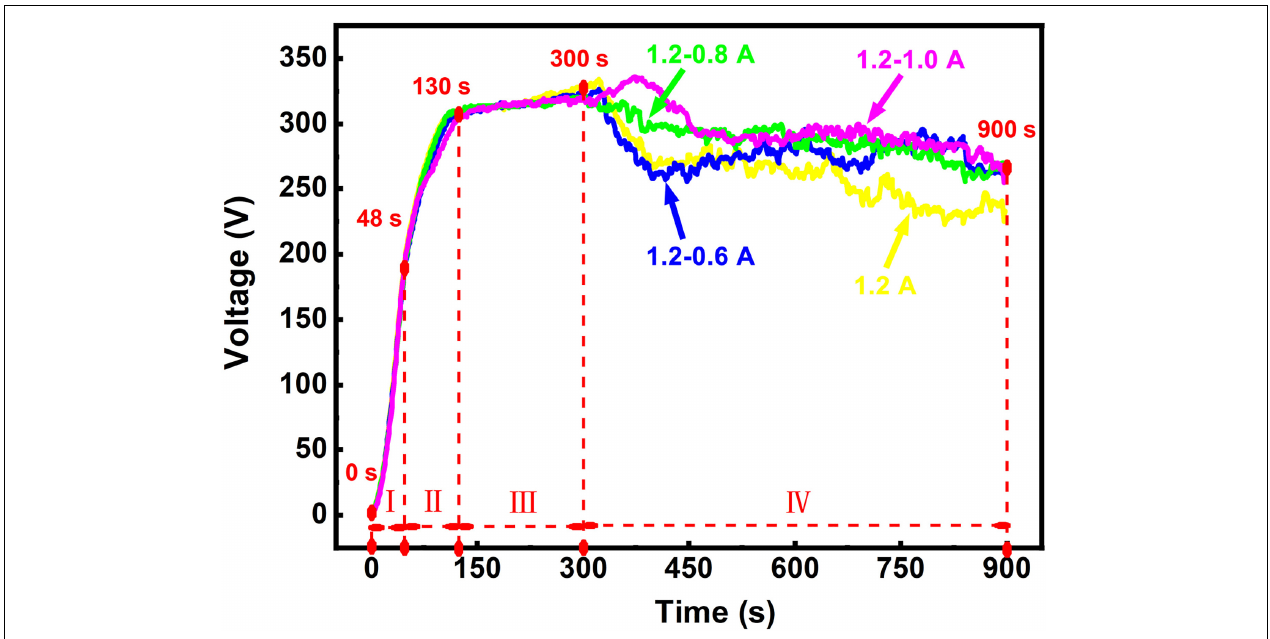
FIGURE 1 | Voltage-time curves during the MAO process under different current modes.